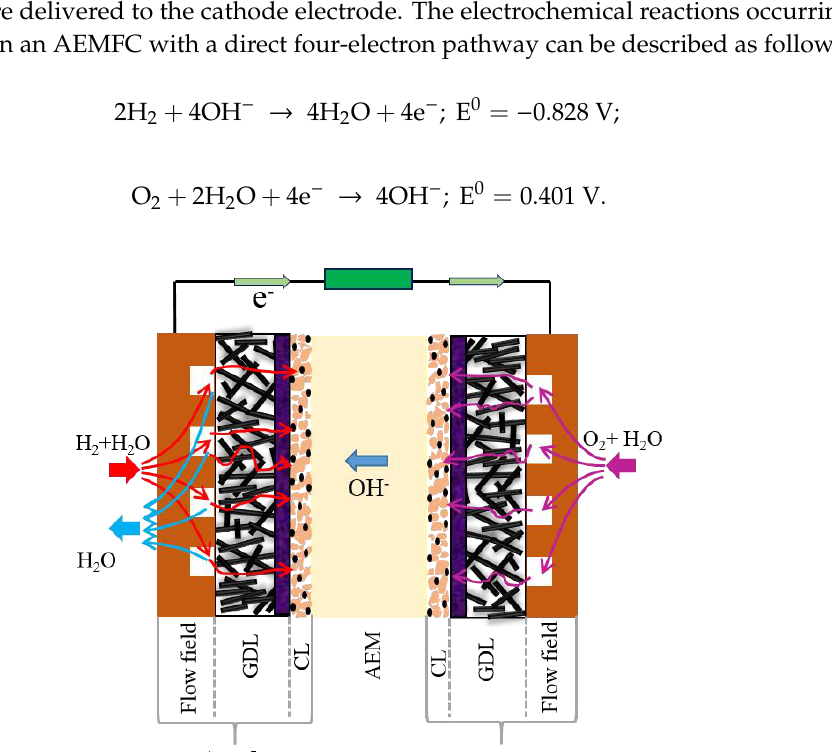
Figure 1. Schematic diagram of an anion exchange membrane fuel cell (AEMFC) GDL, gas diffusion layer; CL, catalyst layer.